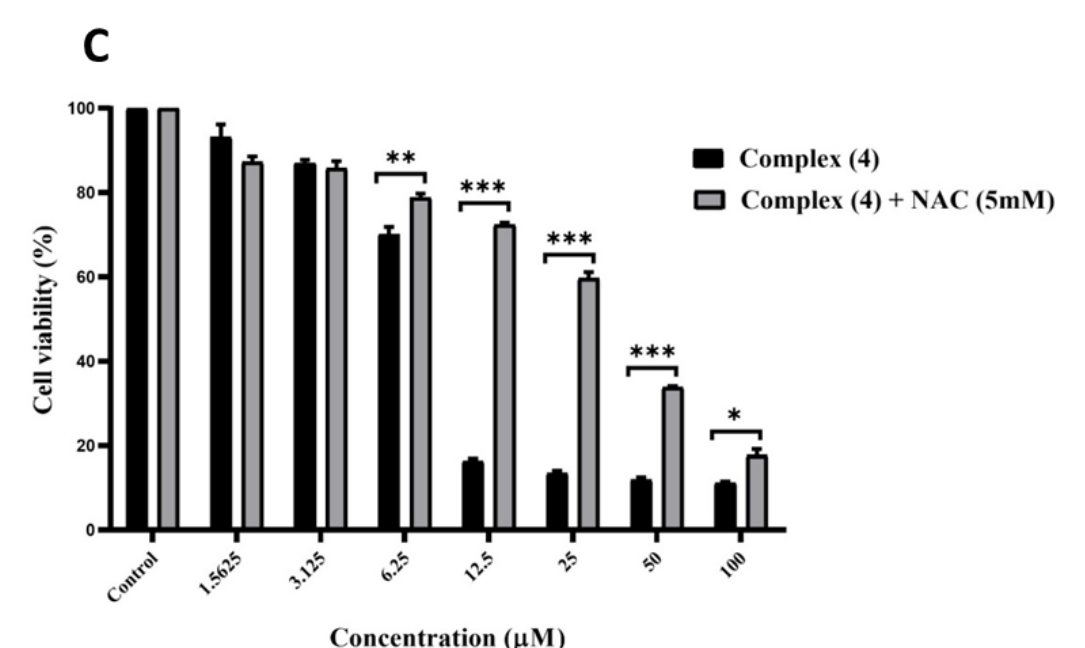
Figure 4. The levels of ROS detected in MDA-MB-231 cells after treatment with 2 × IC 50 of the compounds for 24 h using the H 2 DCFDA fluorescent probe and analyzed by light microscopy and flow cytometry. ( A ) Representative images show increased ROS generation in MDA-MB-231 cells after treatment with compounds. Control cells were treated only with H 2 DCFDA probe. Bars = 20 µ m. ( B ) Quantitative analysis of ROS production by flow cytometry and ROS inhibition of ROS production with NAC 5mM. ( C ) Cellular cytotoxicity evaluation by MTT assay after 48 h of treatment with complex ( 4 ) in the presence or absence of NAC. Data represent the mean ± SD ( n = 3). * Indicates statistical difference (* p < 0.05, ** p < 0.01, and *** p < 0.001).